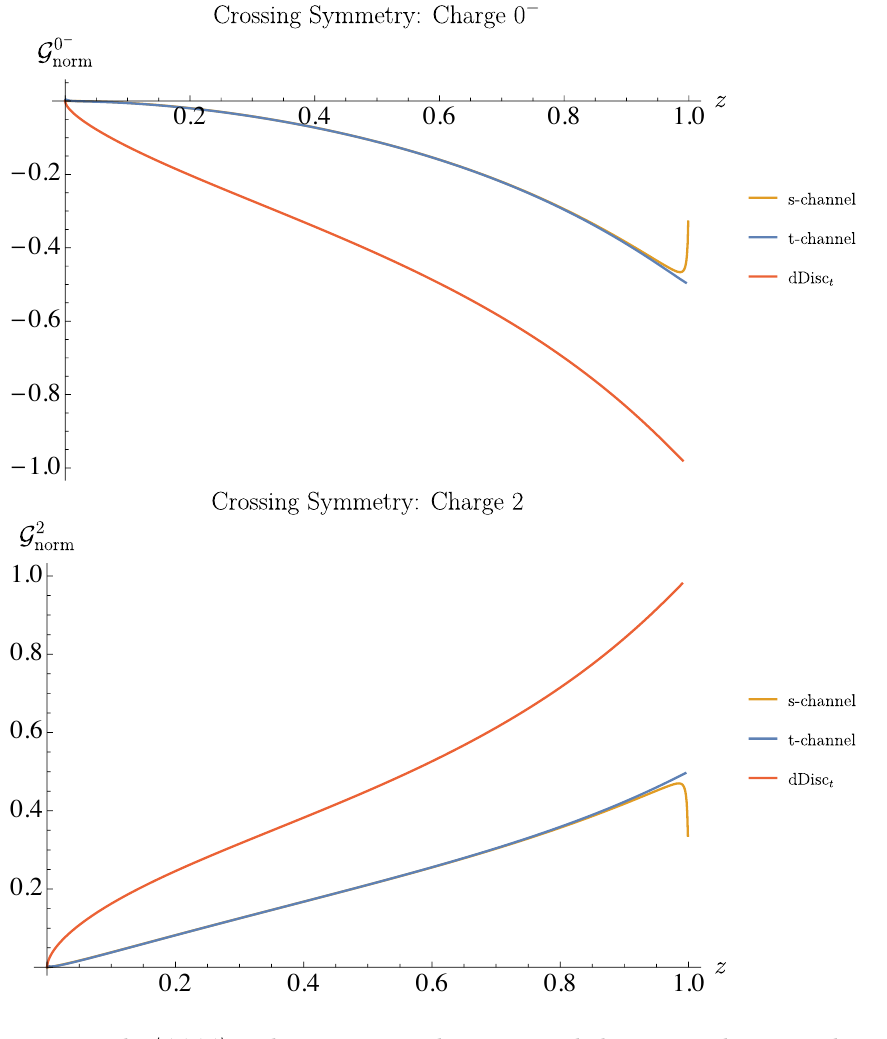
( z; z ), using the norm